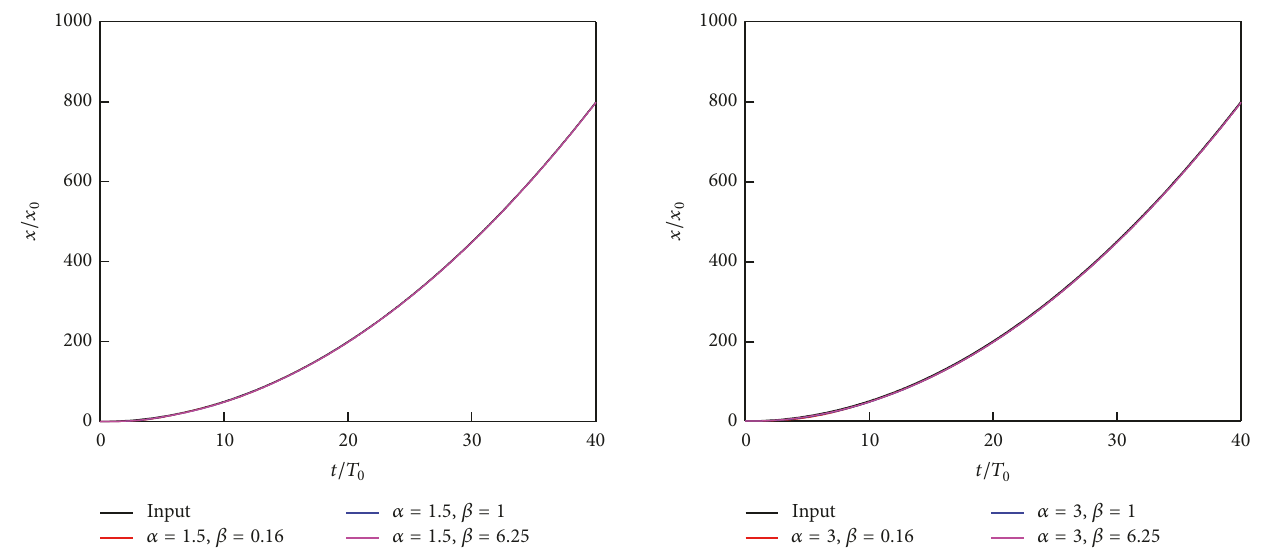
Figure 31: Response in the time domain ( 𝛼 = 3, 𝛽 = 0.16, 1,6.25 ).